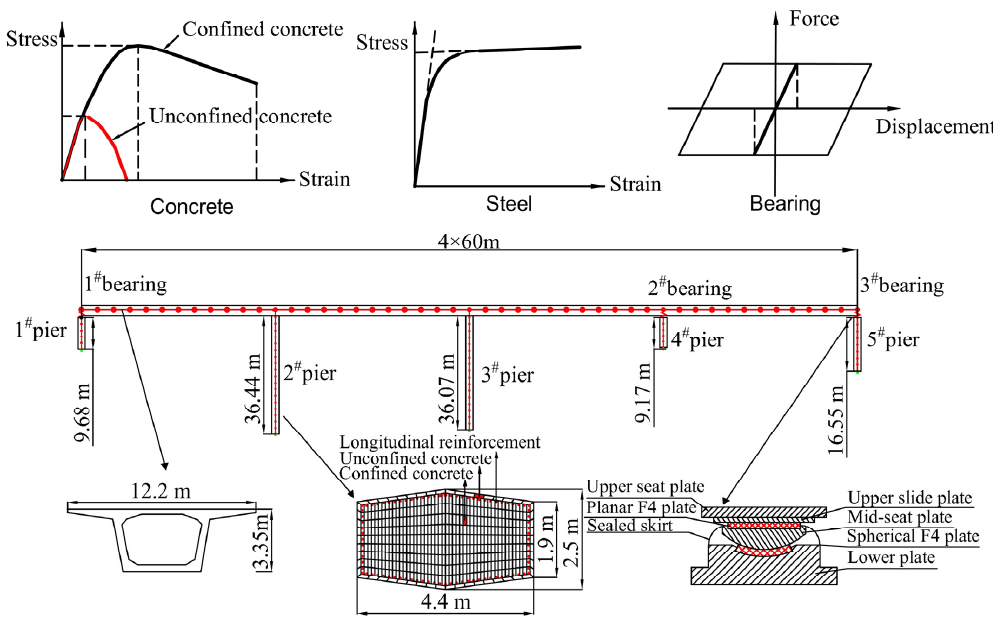
Figure 3. Finite element model and schematic diagram of the